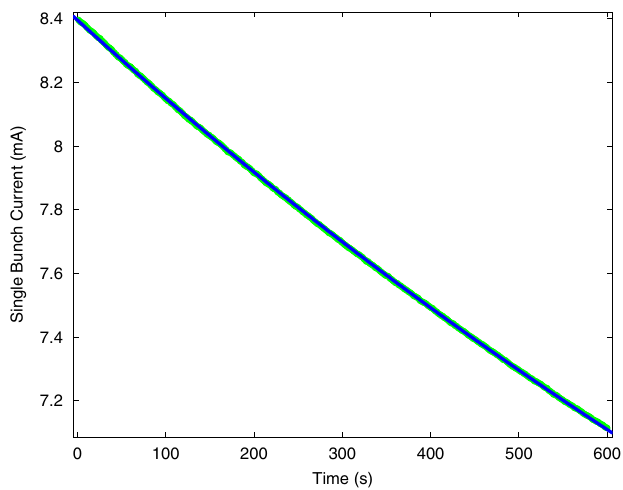
FIG. 11. Example of the beam current decay fit to extract the Touschek component. Data is shown in green; the fit is in blue.